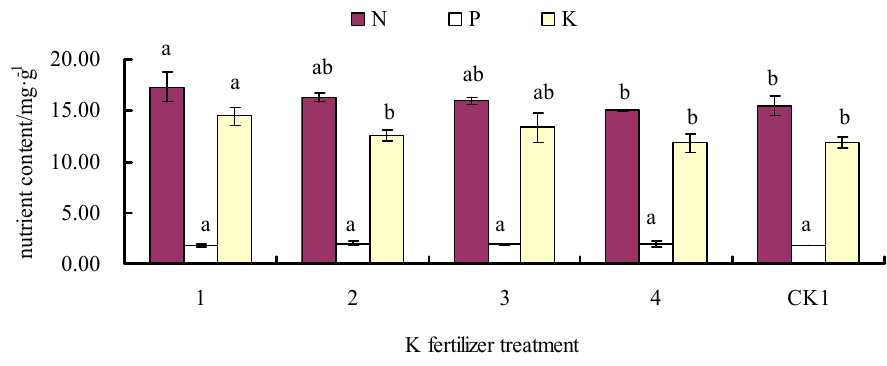
Figure 3. Effects of single K fertilizer application on G. biloba leaf N, P, and K contents in EXP.1.